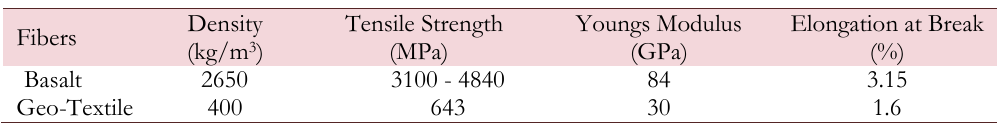
Table 1: Physical and mechanical properties of fibers.